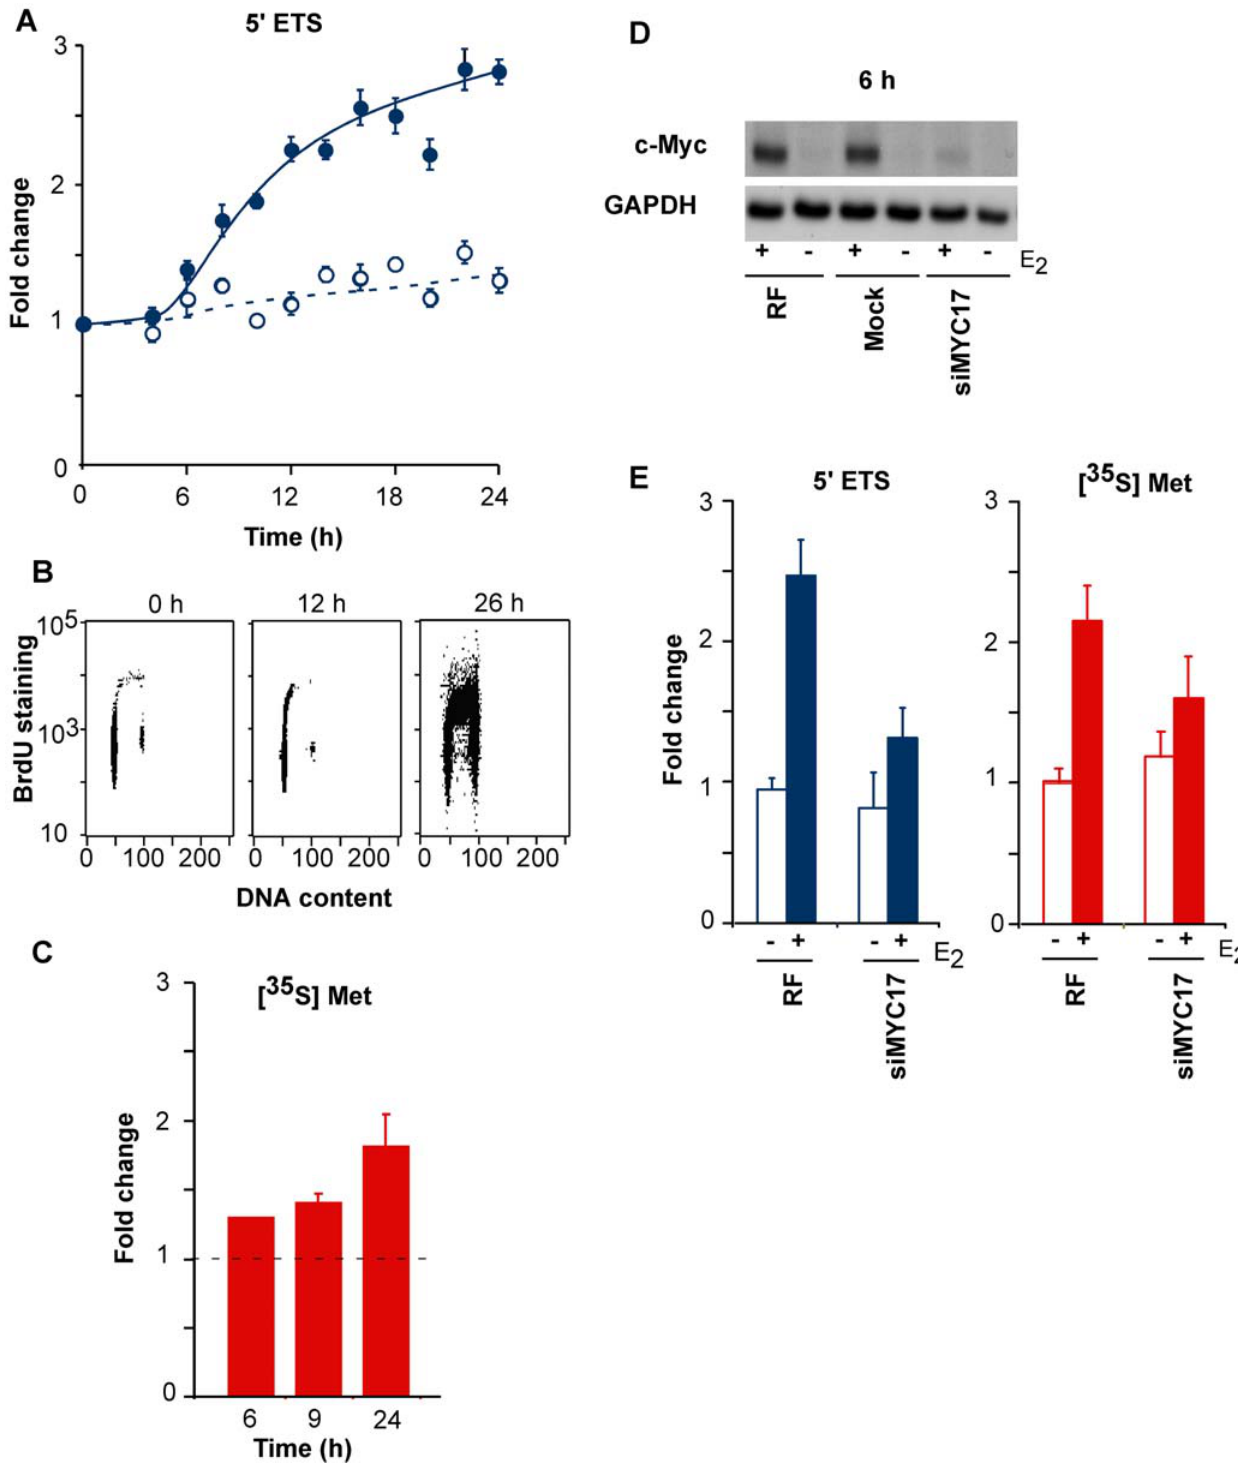
Figure 6. Effect of RNAi-mediated knockdown of c-Myc on cell growth after estrogen treatment. A, B: MCF-7 cells were growth arrested with 10 nM ICI 182780 for 48 h then treated with either 100 nM E 2 or vehicle (ethanol) (A) Abundance of the 5 9 ETS of the 45S rRNA transcript was measured using qRT-PCR. Vehicle control, # open circles; estrogen, $ filled circles. Data are mean 6 SEM of triplicate experiments. (B) Cells treated with E 2 for the indicated times were additionally treated with BrdU 2 h before harvesting. BrdU content (immunofluorescence) and DNA content (propidium iodide staining) were measured using 2 parameter flow cytometry. (C) Overall protein synthesis was measured by [ 35 S]-methionine incorporation at the indicated times after E 2 treatment. Data are mean 6 range or SEM of 2–3 experiments. D, E: Cells were mock-transfected or transfected with 100 nM of control (RISC-free, RF,) or Myc siRNAs (siMYC17), treated with antiestrogen (ICI 182780) for 48 h, and then treated with 100 nM E 2 or vehicle (ethanol). (D) Protein lysates were immunoblotted for c-Myc. (E) 5 9 ETS abundance (qRT-PCR) and protein synthesis ([ 35 S]- methionine incorporation) were measured in the presence of control (RF) and c-Myc siRNAs (siMyc17) in duplicate experiments.